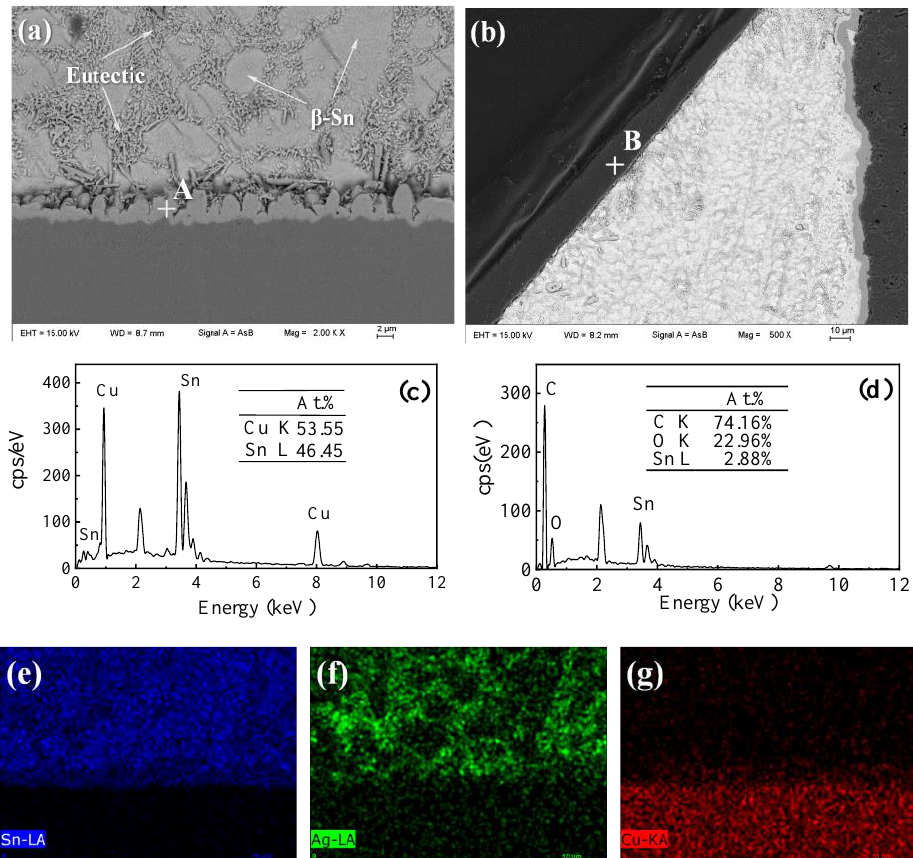
Figure 7. Microstructure analysis of region O and region P in Figure 6: ( a ) SEM image of region O, ( b ) SEM image of region P, ( c ) EDS result of point A, ( d ) EDS result of point B, ( e-g ) EDS elemental mapping results of region O.